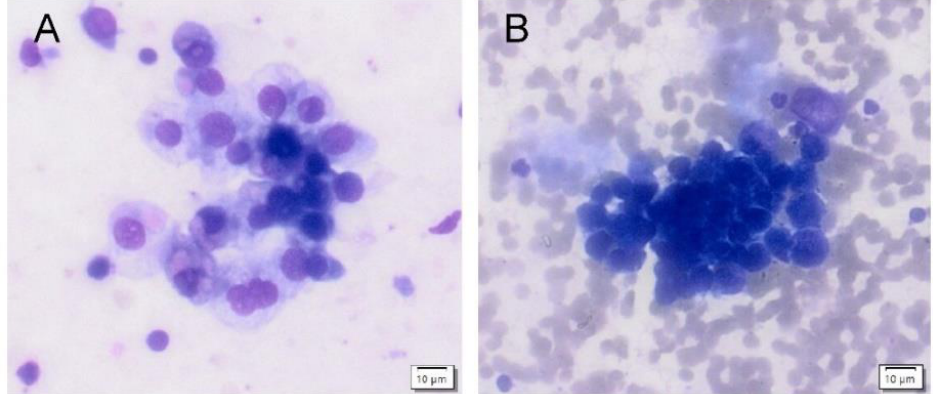
Figure 2. Urine cytology from a healthy volunteer (category shift from TPS3 to TPS5). ( A ): High cellularity specimen from an naive urine (TPS3-atypia) with cohesive clusters of atypic urothelial cells with slightly enlarged nuclei are present. The chromatin is fine, and the nuclear membrane is smooth. ( B ): High cellularity specimen from a postcontrast urine (TPS5–high-grade urothelial cancer) with numerous erythrocytes in the backround. Fewer distinct clusters of small cells are present with enlarged hyperchromatic nuclei with clumped chromatin and irregular nuclear borders. Nuclei are enlarged with higher nucleo-cytoplasmic ratio.